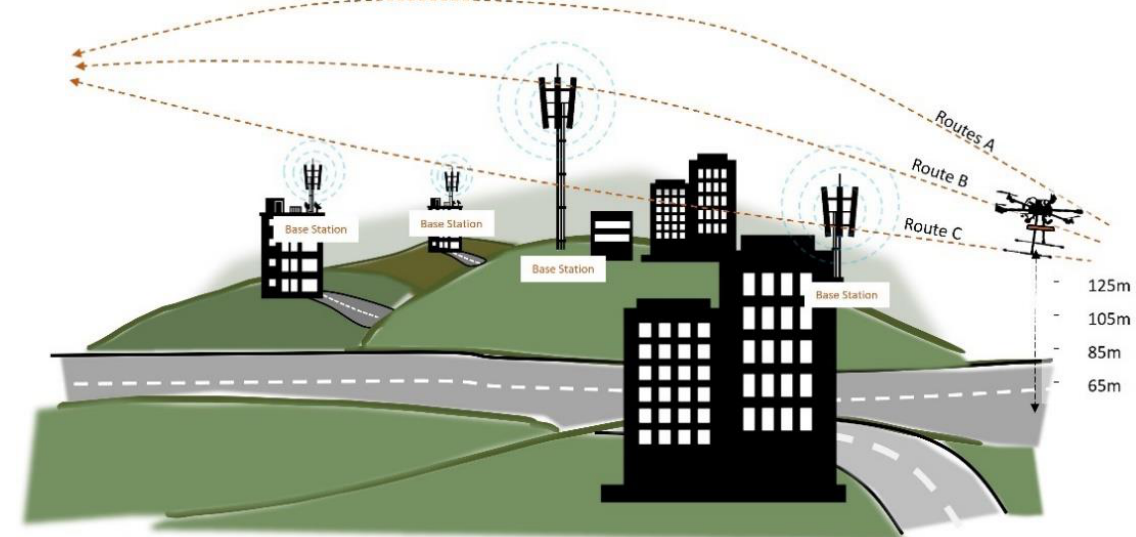
Figure 2. Illustration of the drive test method in three different routes, A-C, and four different heights, 65–125 m.